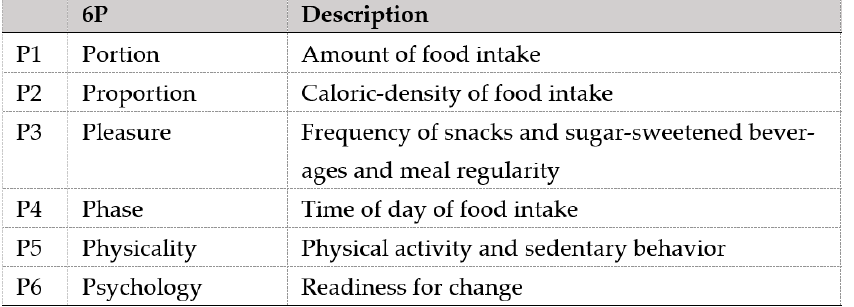
Figure 2. Components of the 6P tool.